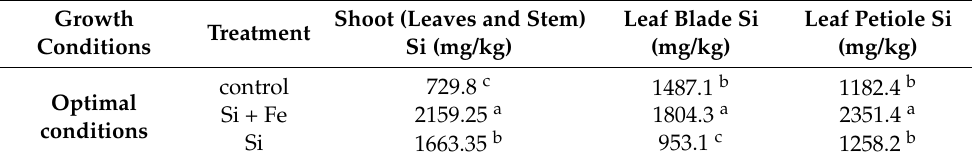
Table 1. Silicon (Si) content in oilseed rape plants under optimal conditions.